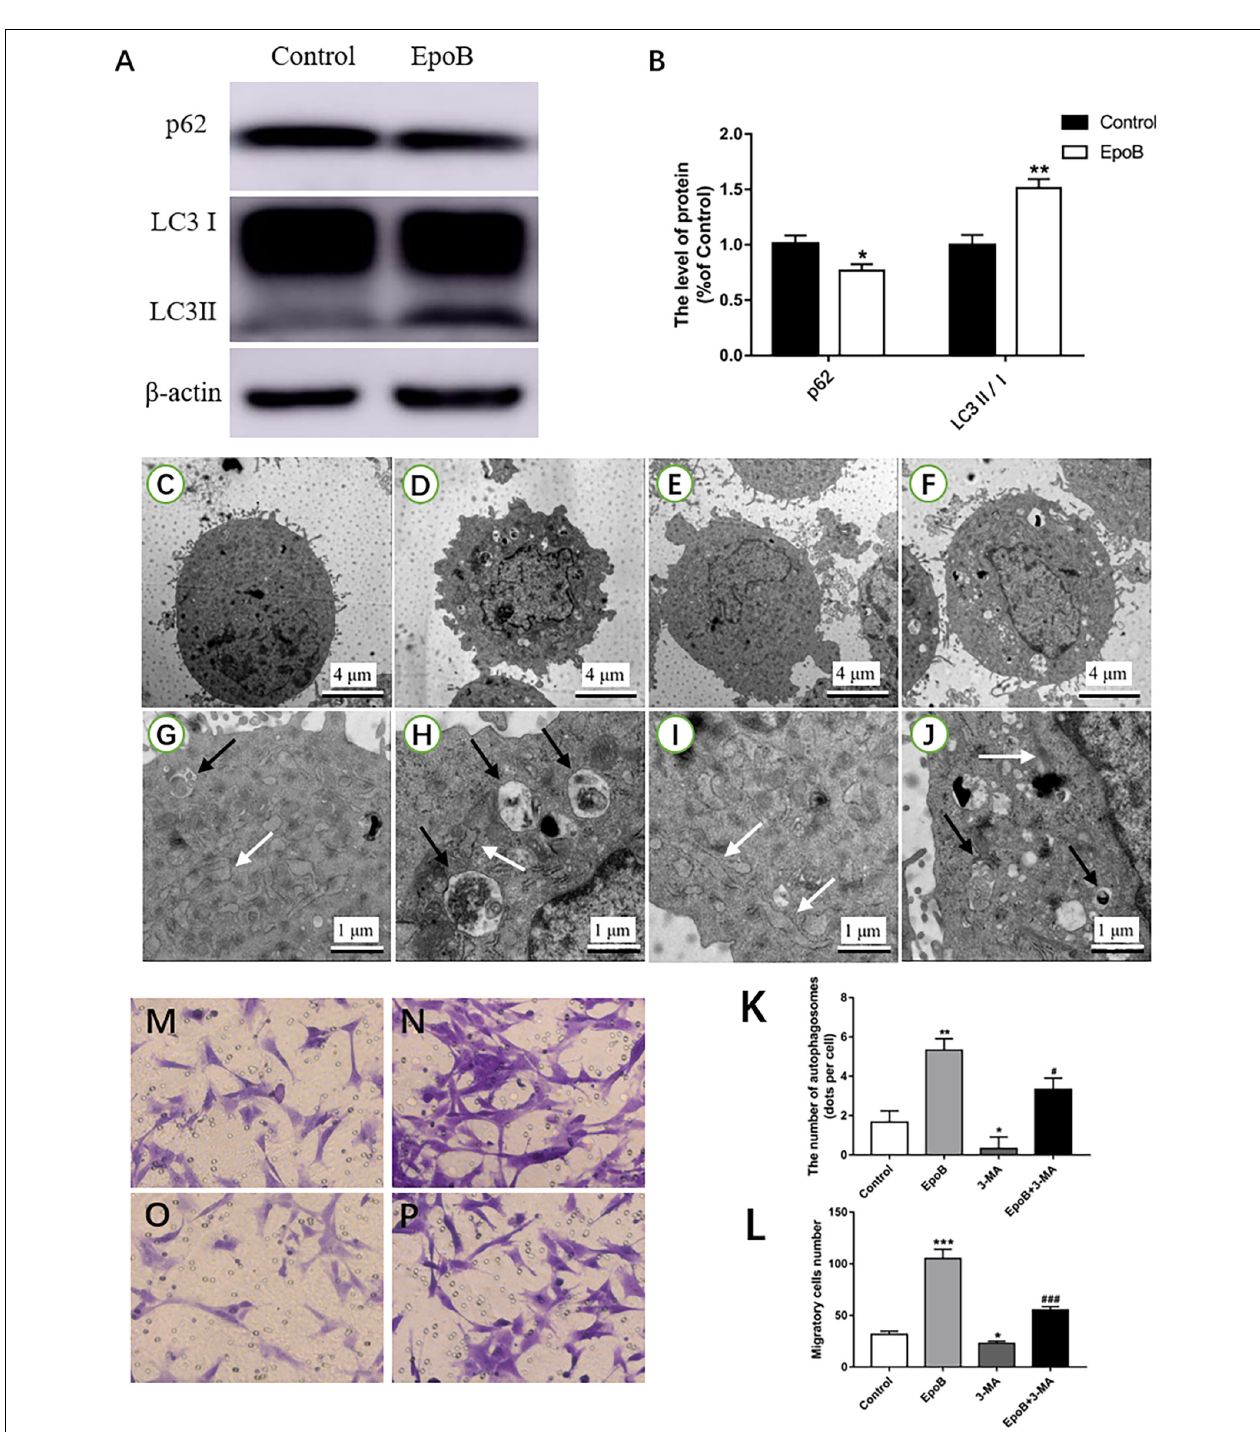
FIGURE 6 | EpoB increases migration of SCs by promoting autophagy. Representative western blotting (A) and data analysis of LC3 and p62 in each group (B) . TEM analysis showing the presence of autophagosomes in SCs from the control (C,G) , EpoB (D,H) , 3-MA (E,I) , and EpoB+3-MA (F,J) groups. White arrowheads indicate normal endoplasmic reticula; black arrowheads indicate double-membraned autophagosomes. (K) Quantification of the total number of autophagosomes in each group. Transwell analysis of migratory cells in the control (M) , EpoB (N) , 3-MA (O) , and EpoB+3-MA (P) groups at 24 h after treatment. (L) Quantification of the total number of migratory cells in each group. Scale bars: (C–F) 4 µ m; (G–J) 1 µ m. * P < 0.05, ** P < 0.01, and *** P < 0.001 compared to the control group; # P < 0.05 and ### P < 0.001 compared to the EpoB group. Abbreviations: EpoB, epothilone B; 3-MA, 3-methyladenine; SCs, Schwann cells; TEM, transmission electron